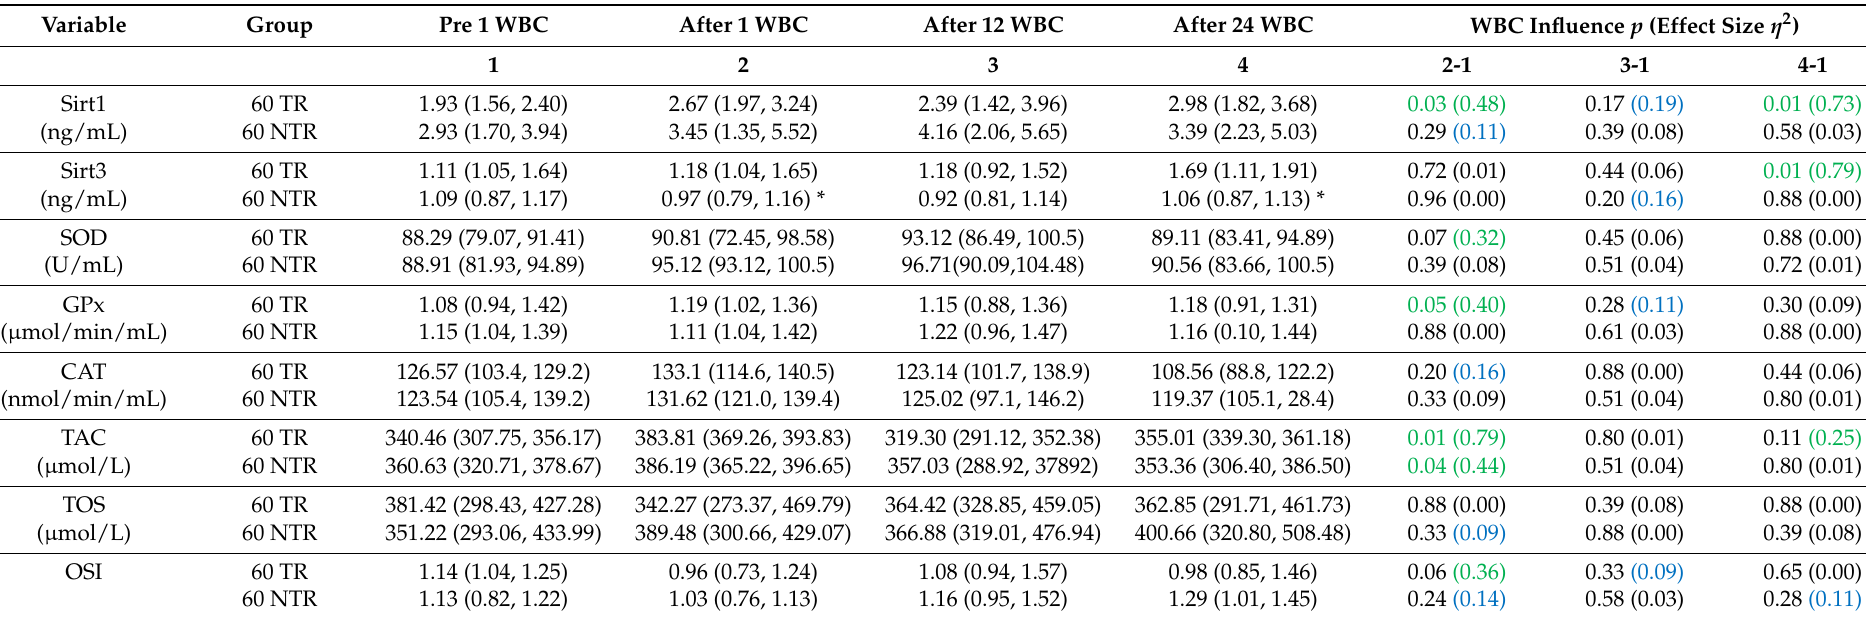
Table 3. Level of sirtuins and markers of oxidative stress in older male before and after the application of whole-body cryotherapy